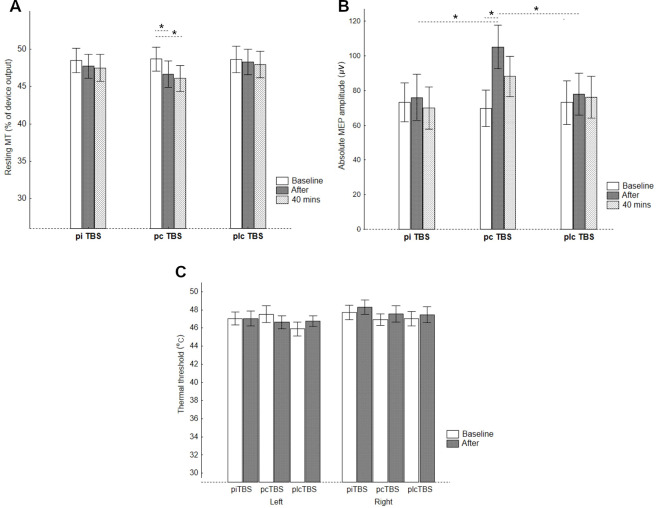
CE represented by (A) RMTs, (B) absolute MEP amplitudes, and pain perception represented by (C) thermal thresholds for the thenar of the left and right thenar eminences after prolonged TBS (pTBS). pcTBS: continuous pTBS; piTBS: intermittent pTBS; plcTBS: placebo TBS. The data are presented as mean ± SE. *p < 0.05 after Bonferroni’s test.